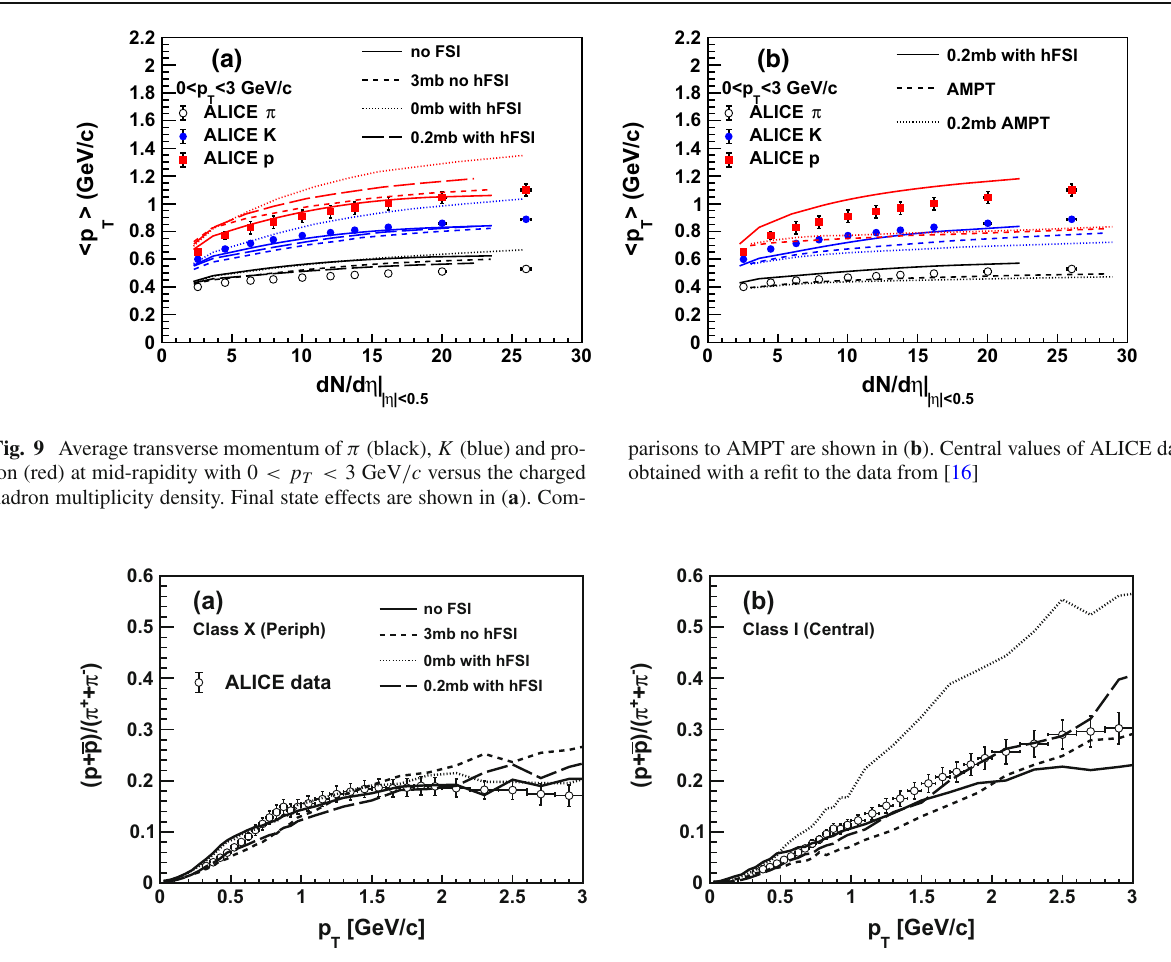
Fig. 10 p T -differential p /π ratio at mid-rapidity in event class X for peripheral collisions ( a ) and in event class I for central collisions ( b ) with no final state interactions (solid line), only parton rescatterings